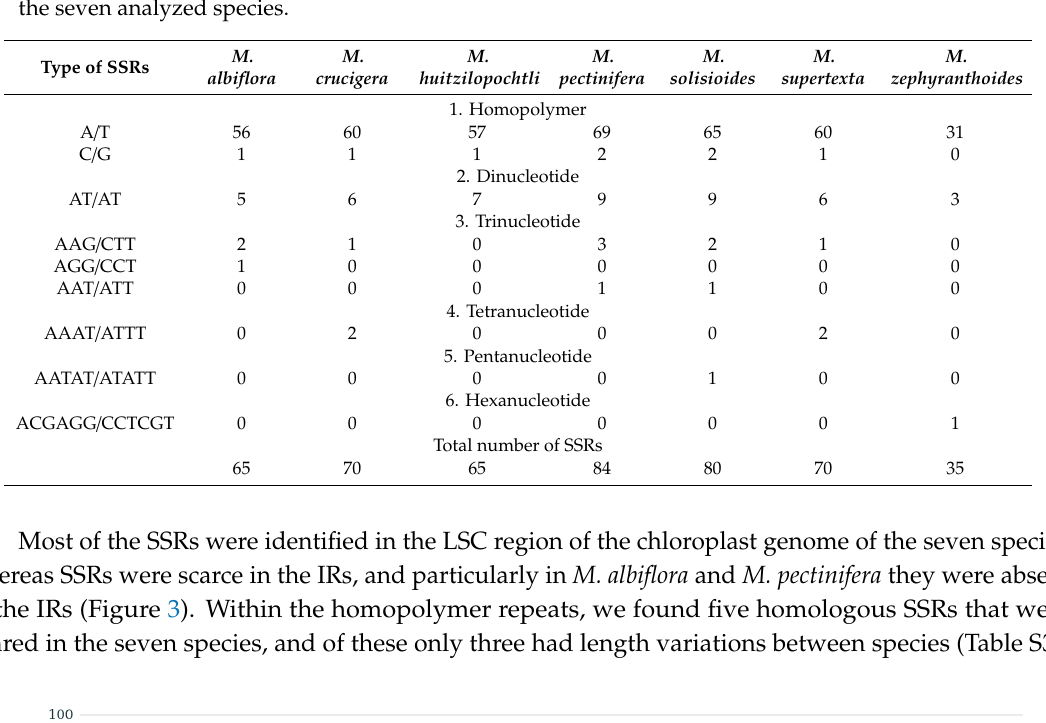
Table 1. Type and number of Short Sequence Repeats (SSRs) in the complete chloroplast genomes of the seven analyzed species.